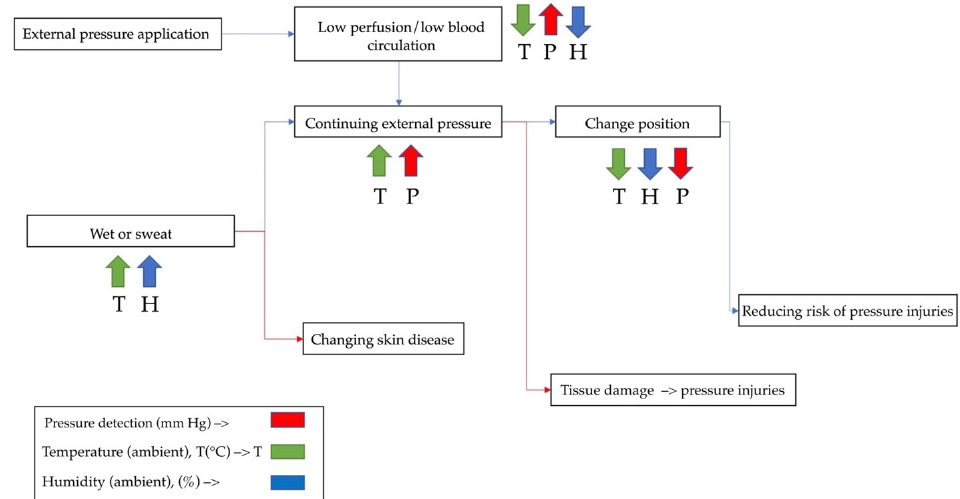
Figure 2. Detection procedures.